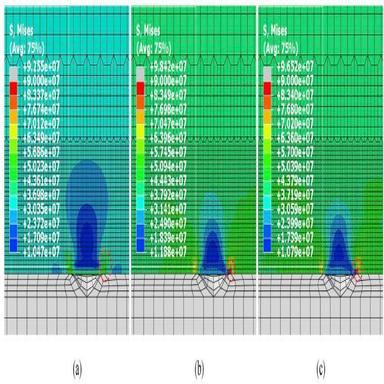
Stress distribution in PTFE composite sliding again steel surface with medium coverage (1.6%) of Type B (narrow & shallow) dimples at (a) start of the sliding (b) first step of sliding (c) steady state of sliding.